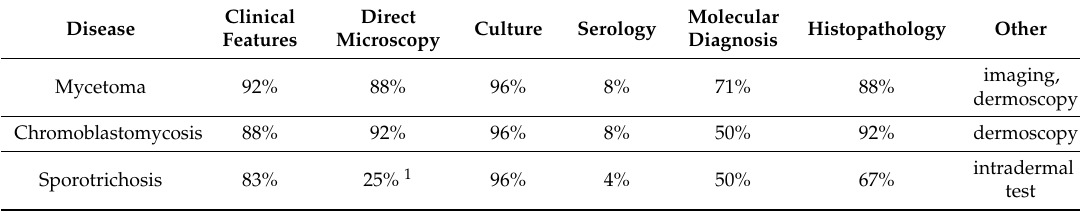
Table 1. Optimal diagnostic methods in a well provided laboratory—positive responses.